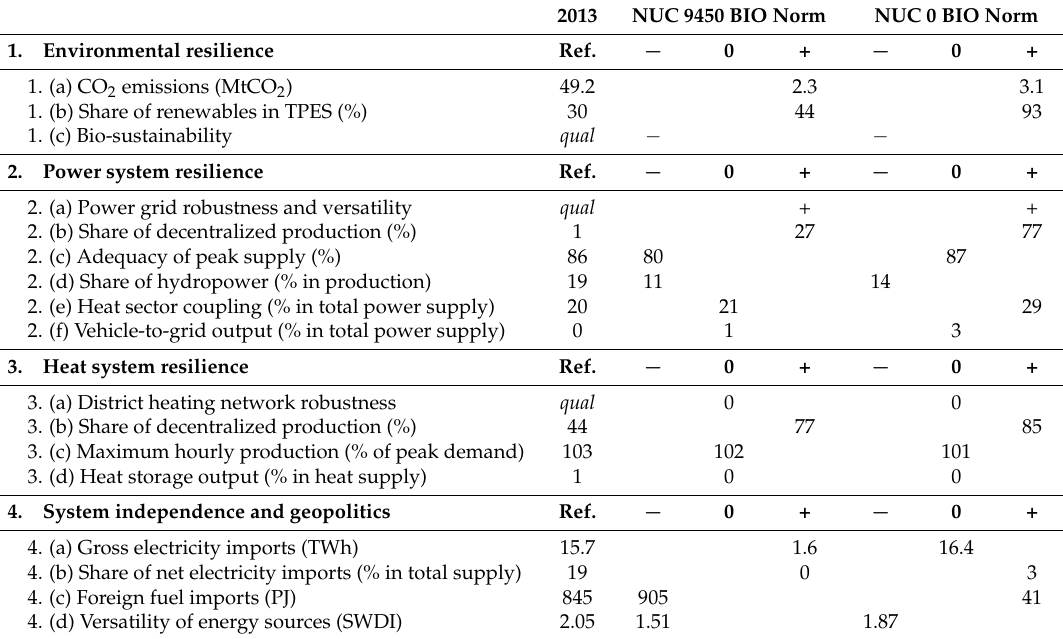
Table 5. Resilience factors and their development in two national case scenarios. Positive changes with respect to resilience are shown in +-column, negative changes in − -column, and if no significant change occurs, the new value is in 0-column. Factors marked with ‘ qual ’ in the Ref. column are analyzed qualitatively ( − = reduced resilience, 0 = neutral, + = increased resilience).